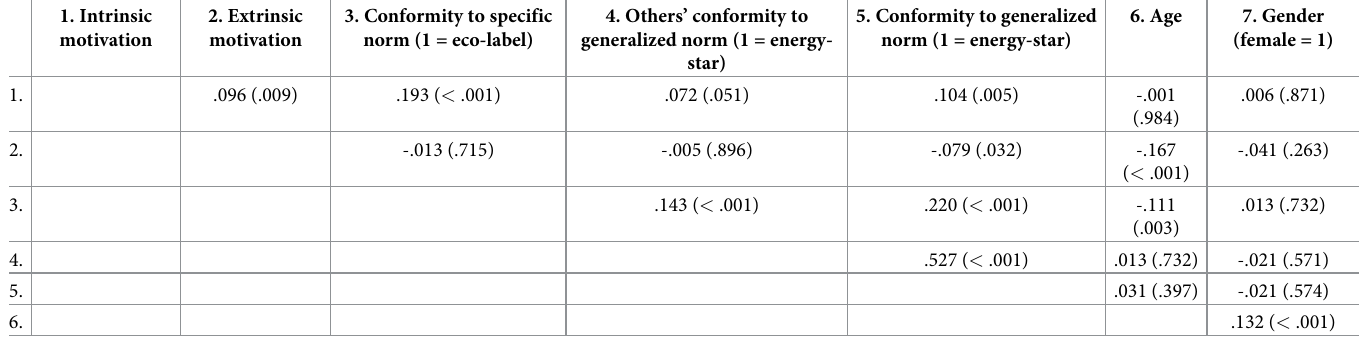
Table 2. Correlation table with all measured